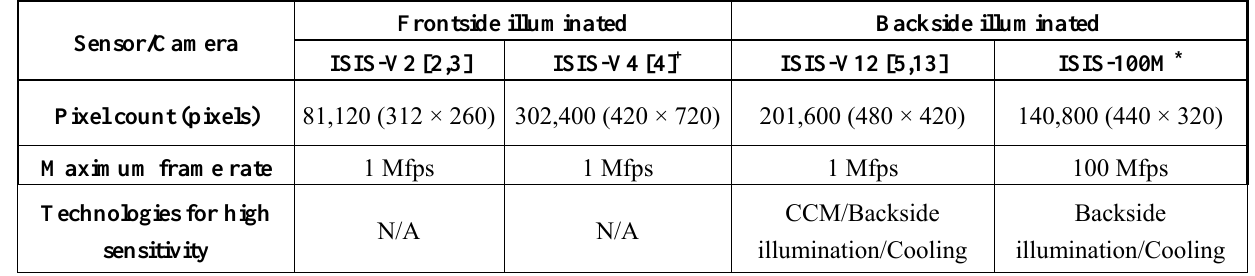
Table 1. Development of ISIS image sensors at Kinki University,